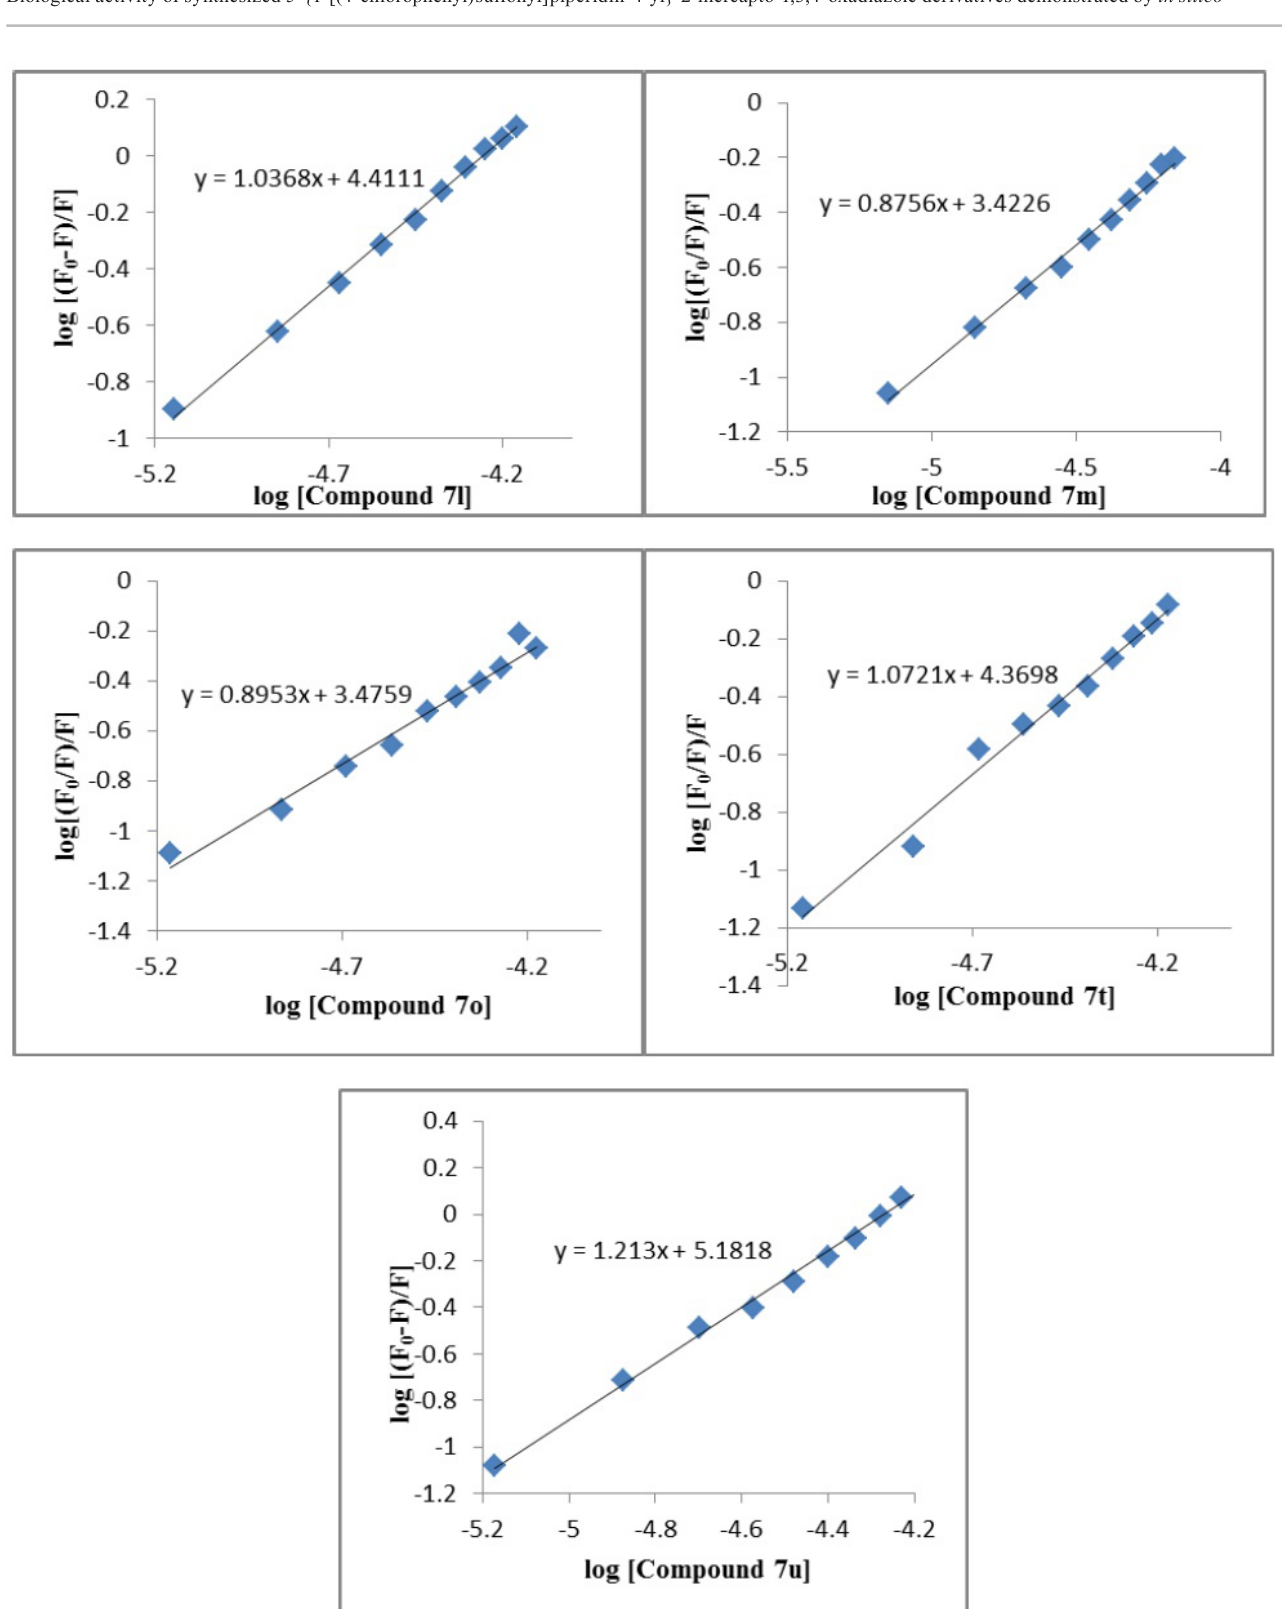
FIGURE 5 - Double logarithm plots of compounds 7l , 7m , 7o , 7t and 7u